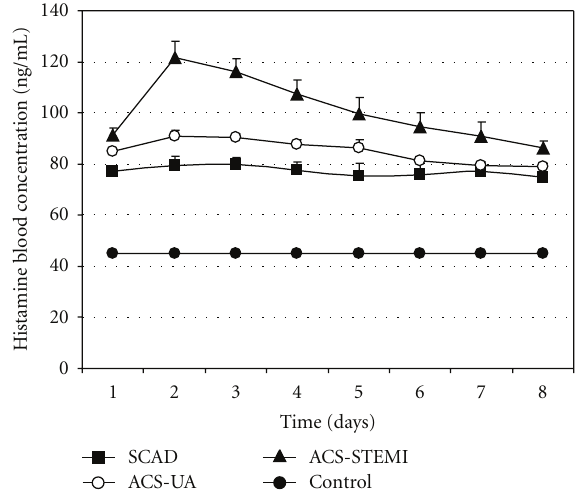
Figure 1: Histamine blood concentration (ngmL − 1 ) in control group ( n = 32), as well as in the patients with coronary diseases: stable coronary artery disease (SCAD, n = 28), acute coronary syndrome, nonocclusive type (ACS-UA, n = 26), and acute coronary syndrome, occlusive type (ACS-STEMI, n = 37), during the testing period of eight days. The data are presented by means ± SEM.